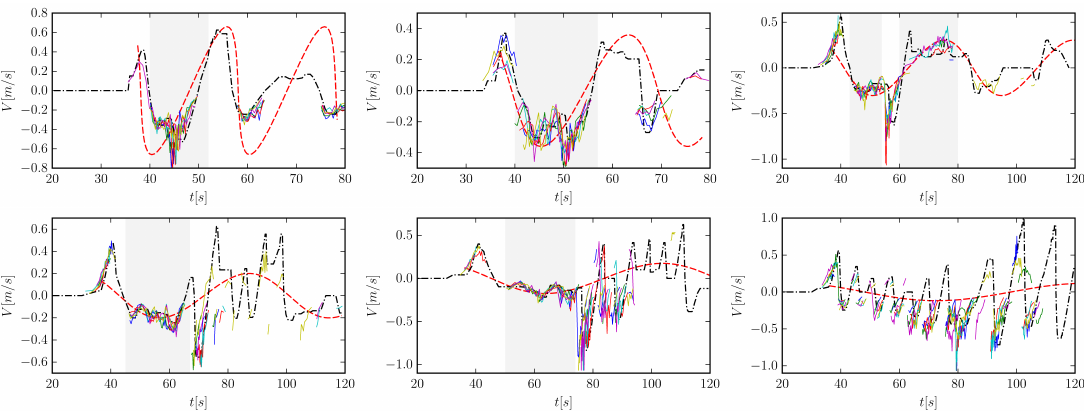
Figure 8. Same as Figure 7, but for run-up velocity V . The shaded regions depict the intervals where the extreme values for the diagrams in Figure 10 were